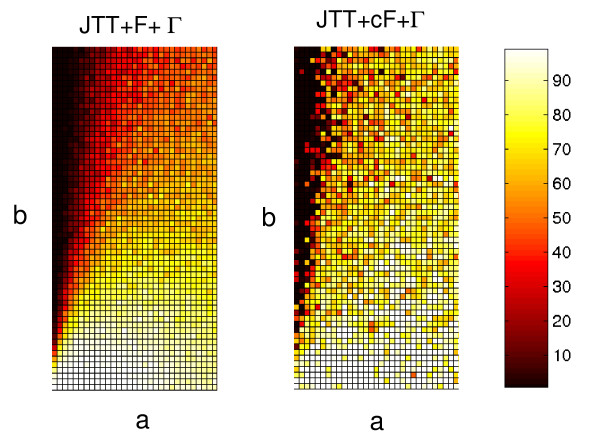
The performance of ML tree reconstruction with the JTT + F + Γ model and the JTT + cF + Γ model. The data were simulated under the site-specific frequency model (JTT + ssF + Γ) based on amino acid frequencies observed at each site of the HSP90 alignment. The ranges of branch-lengths a and b are 0.05–1.45 and 0.5–2.95, respectively, with an increment of 0.05. The left and right heatmaps represent, respectively, the proportions of correctly estimated trees estimated under JTT + F + Γ and JTT + cF + Γ models. Each box of the heatmaps represents 100 simulations for the given conditions.